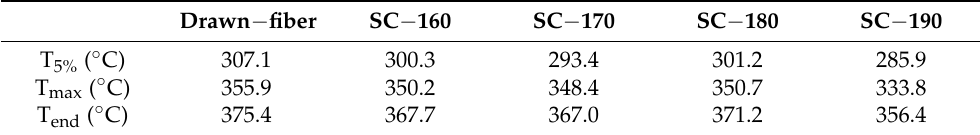
Table 3. Thermal decomposition temperature of drawn − fiber and SC − PLA fiber.